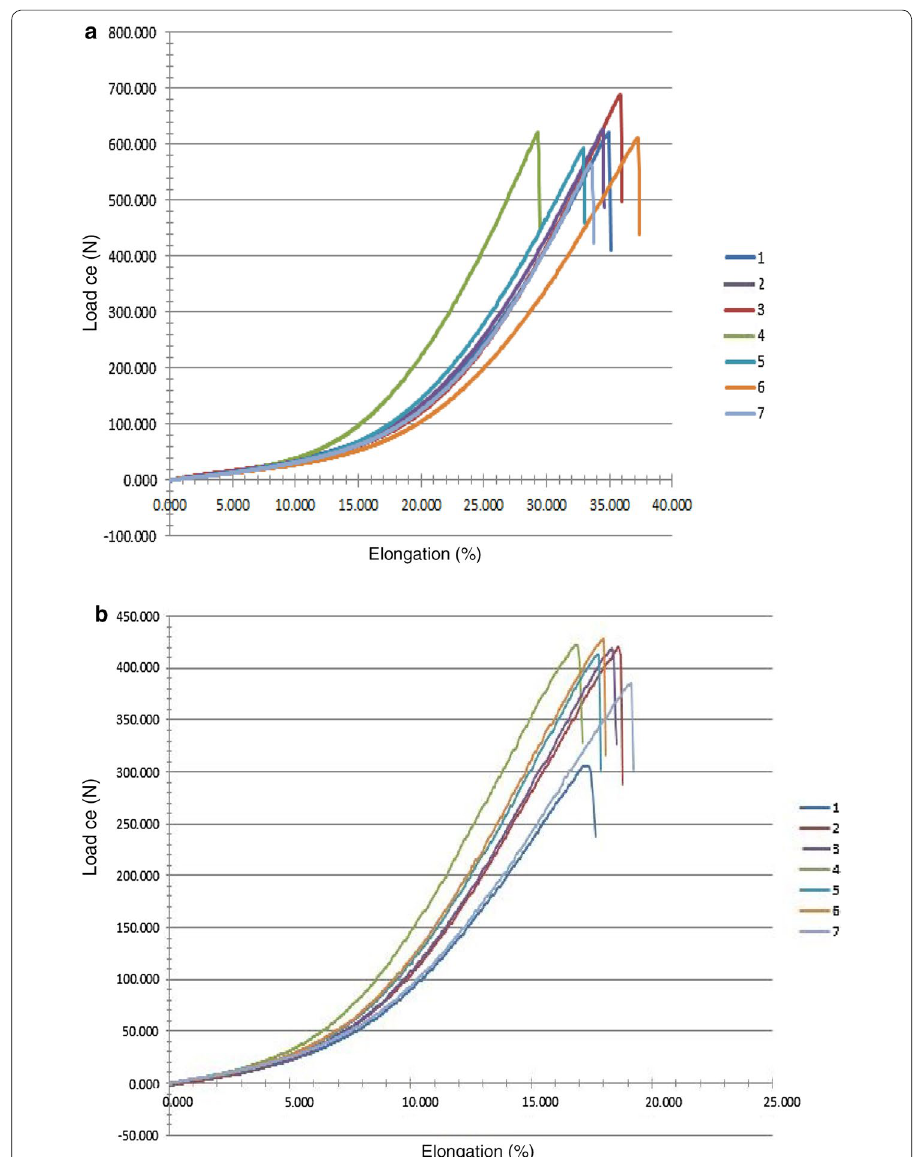
Fig. 8 Load-elongation curve of finished fabric both in warp ( a ) and weft ( b )